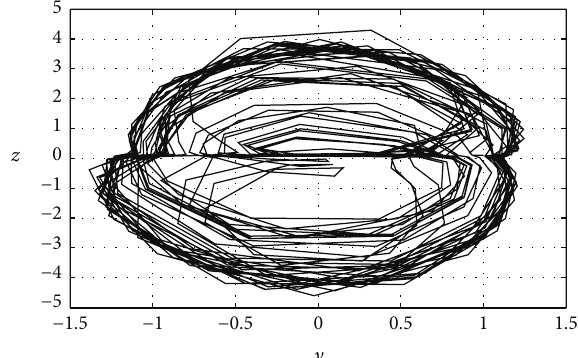
Figure6:3DDuffingchaoticsystemphasediagraminthe 𝑥𝑜𝑦 plane projection.